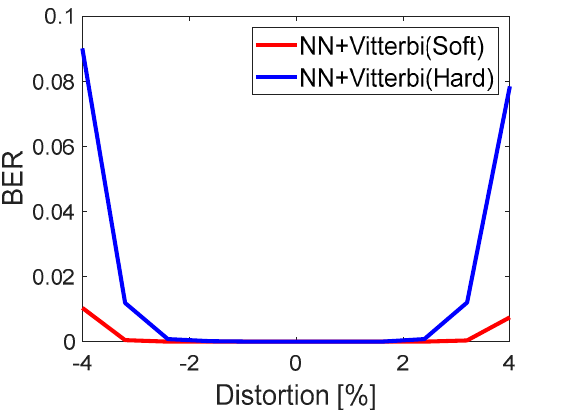
FSK dem.+Vitterbi(Soft) FSK dem.+Vitterbi(Hard)